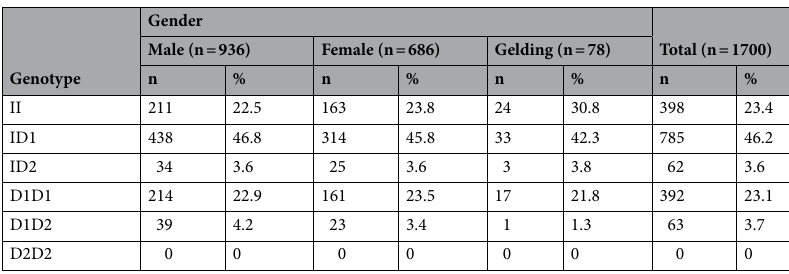
11.0% for mice, respectively 7 . The proportion of histidine residues was lower in horses with insertion type eHRG than in humans and mice, whereas the proportion of proline residues was 16.3%, 12.4%, and 9.9% in horses, humans, and mice, respectively, indicating a tendency for more proline residues in horses than in humans and mice 7 .